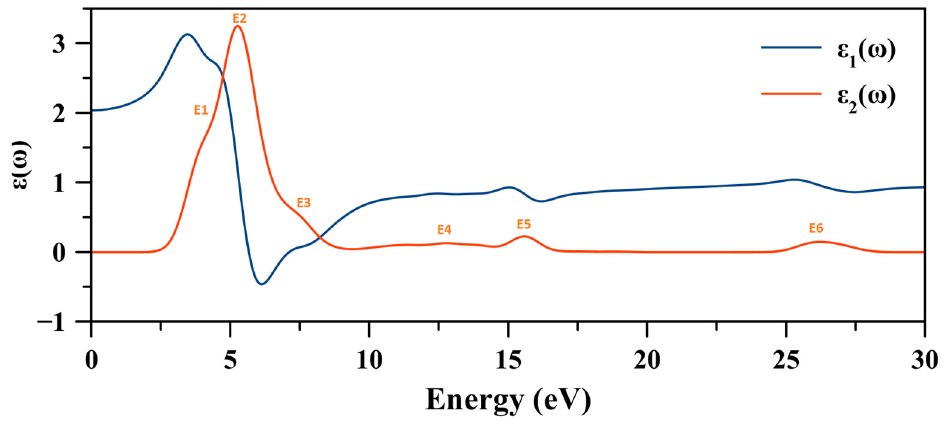
Figure 12. Variation of the unpolarized real and imaginary parts of the dielectric function showing the presence of six transitions.